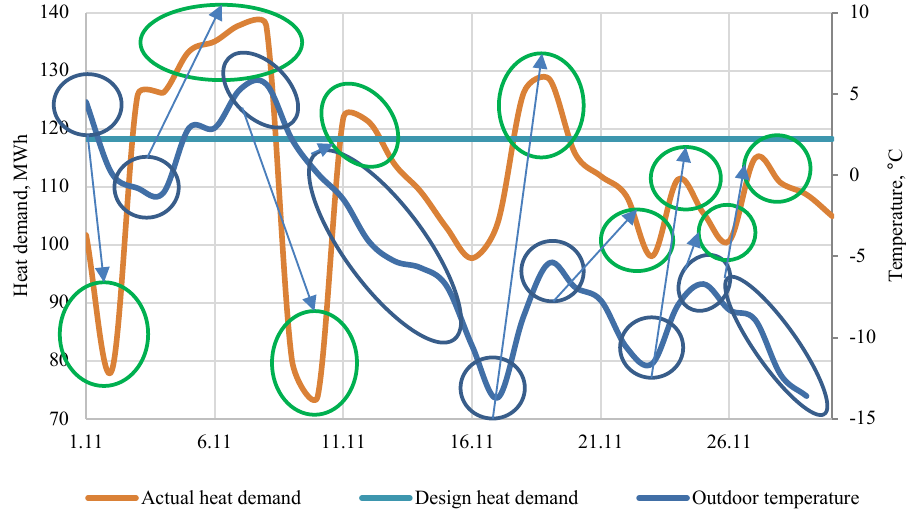
Fig. 6. Correlation between outdoor temperature and heat